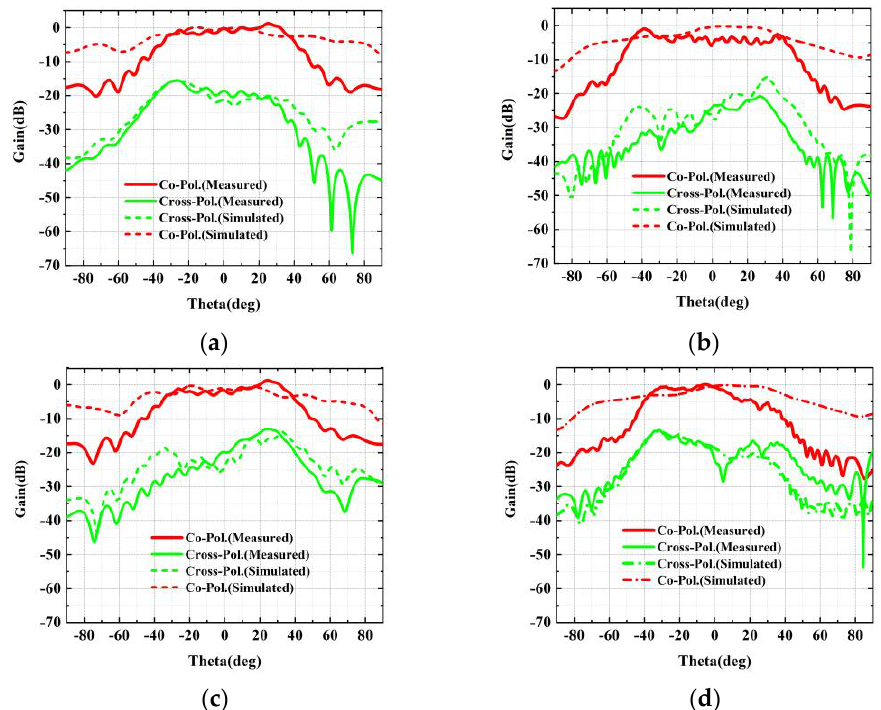
Figure 7. Active element patterns of the central ports (9, 8) of the proposed array. ( a ) E ₋ plane at 4 GHz. ( b ) E ₋ plane at 20 GHz. ( c ) H ₋ plane at 4 GHz. ( d ) H ₋ plane at 20